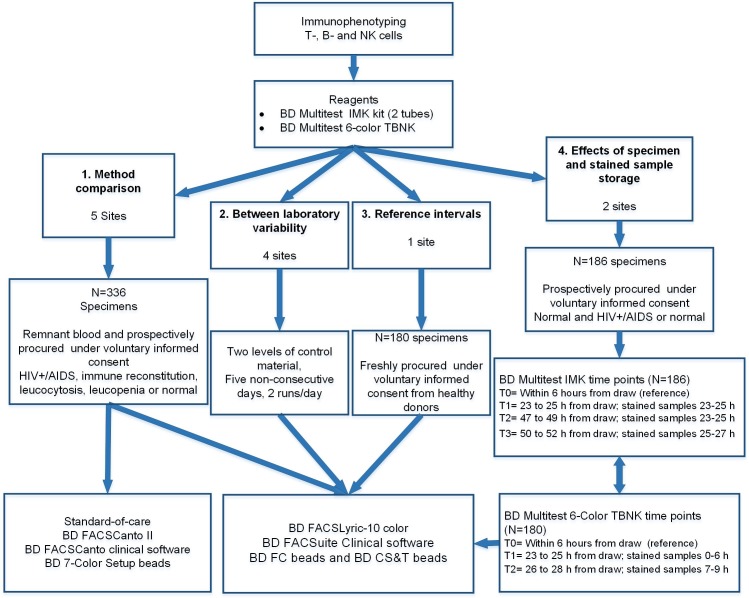
BD FACSLyric clinical evaluation flowchart.T-, B-, and NK cells were stained with BD Multitest reagents for testing of the 4 protocols depicted from the left to the right side: 1. Method comparison; 2. Inter-laboratory variability; 3. Determination of the reference intervals and 4. Evaluation of the specimen and stained sample storage. The summary for each protocol includes the number of specimens enrolled and cohort of origin, followed by the instrument(s) used for acquisition of the stained sample.